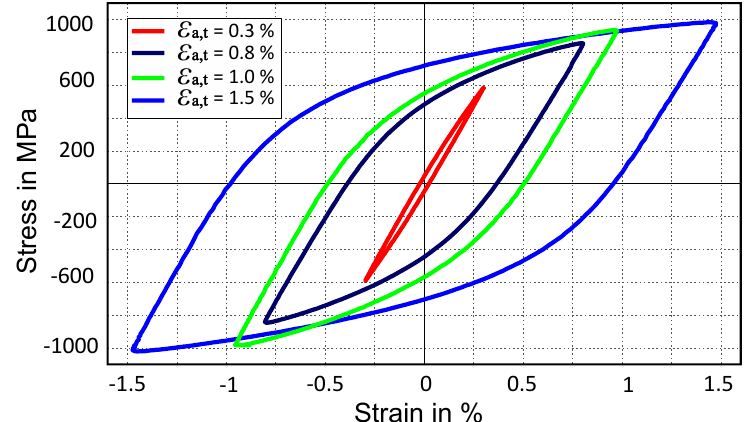
Figure 8. Experimental stabilized stress-strain hysteresis loops at half normalized lifetime for di ff erent total-strain amplitudes.